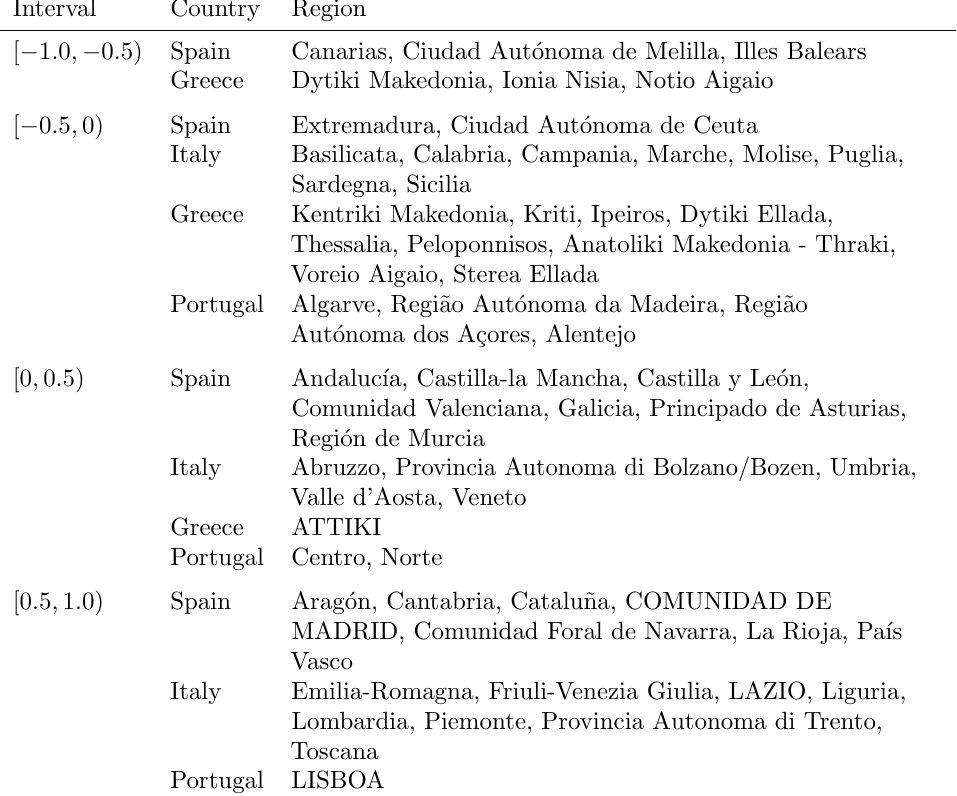
Table A.6: Overall classification of the south European regions based on their Basic Image Interval Country